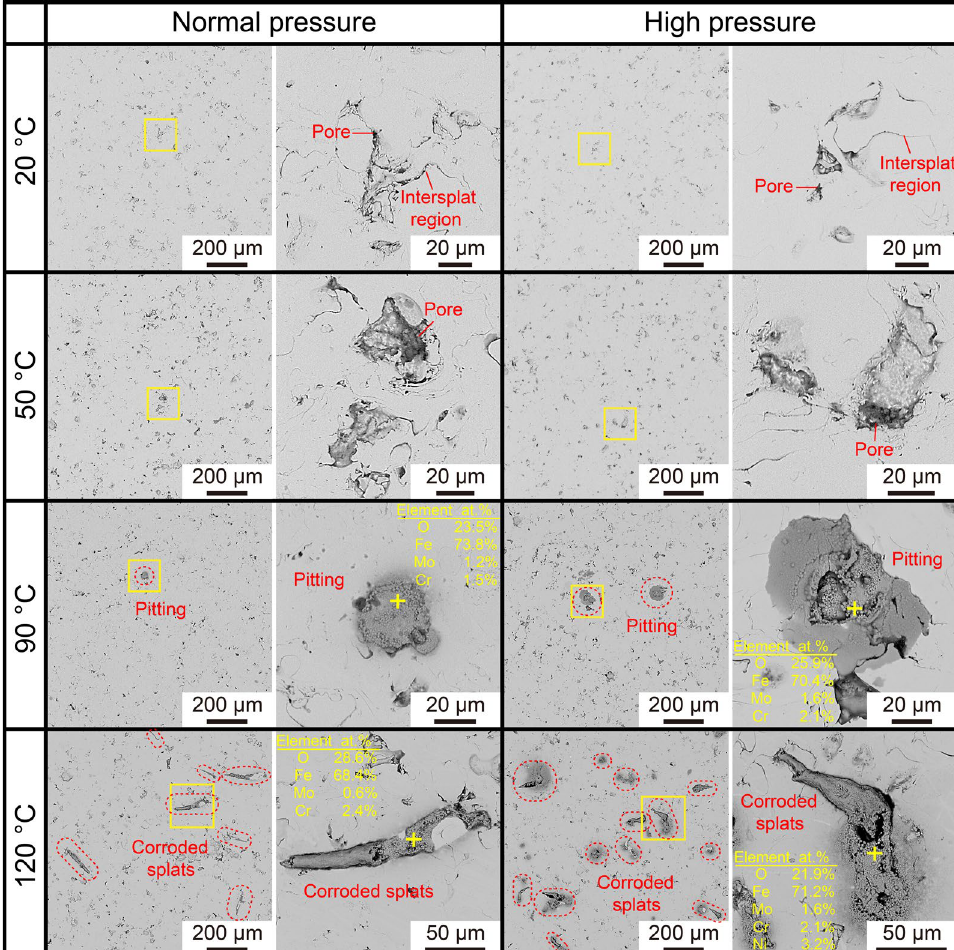
Figure 9. SEM-BSE micrographs of the coated Mg-RE alloy after 5-day immersion in 3 wt.% KCl solution under various temperatures and pressures.